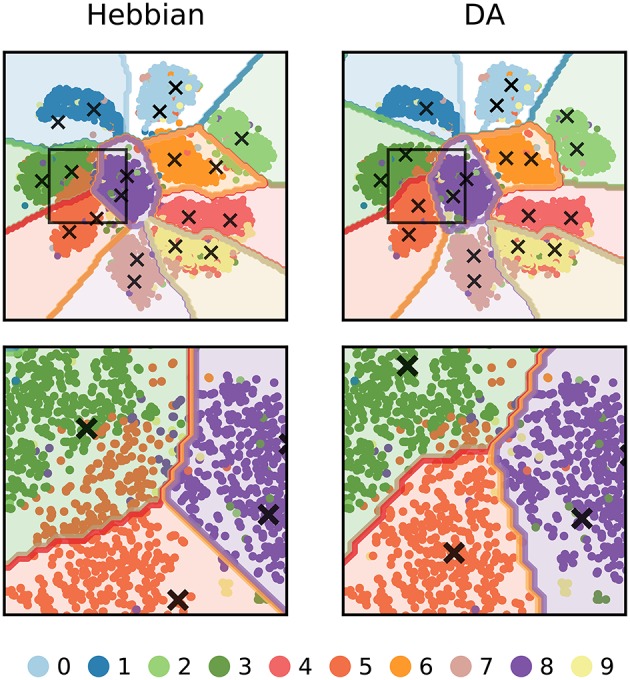
2-dimensional visualization of the outcome of DA learning. The dimensionality of input images are reduced from 784 to 2 features and a network is trained on these data. The input stimuli are depicted as colored dots, the weights of representation neurons as black crosses, and the classification boundaries as colored outlines. Hebbian learning performs density estimation: weights represent clusters of data points agnostic to the points' labels. For classes that are well separated from others, the network retrieves close to perfect boundaries (e.g., “1” or “0”). However, for close-by classes (e.g., “3”, “5”, and “8”, magnified in the bottom row), the boundaries poorly match the true labels. DA transmission adapts weights so that they better agree with the class boundaries of the task.